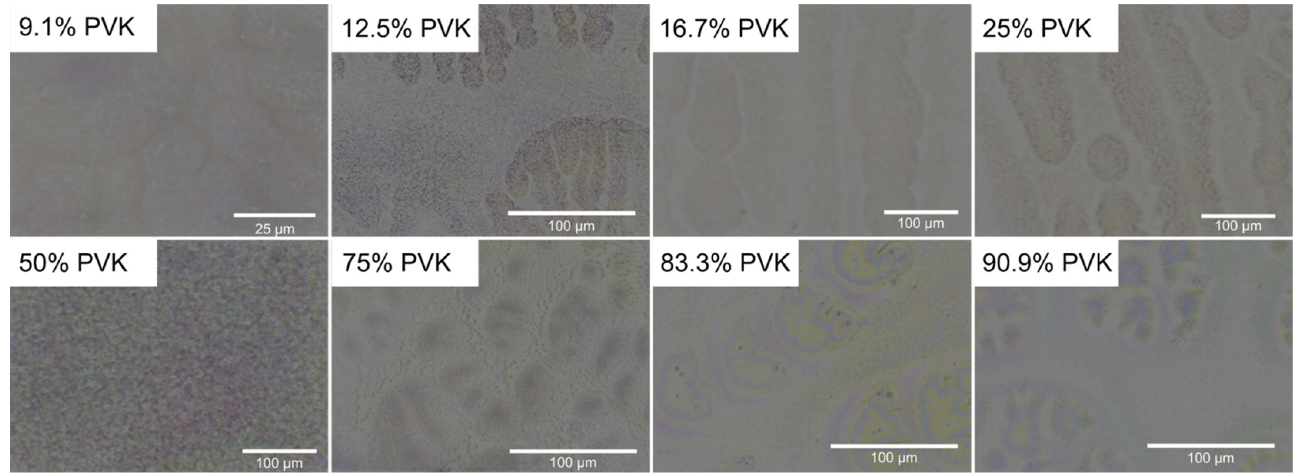
Figure 1. Light microscope images (reflection mode) of samples containing 9.1%, 12.5%, 16.7%, 25%, 50%, 75%, 83.3%, and 90.9% of PVK content.